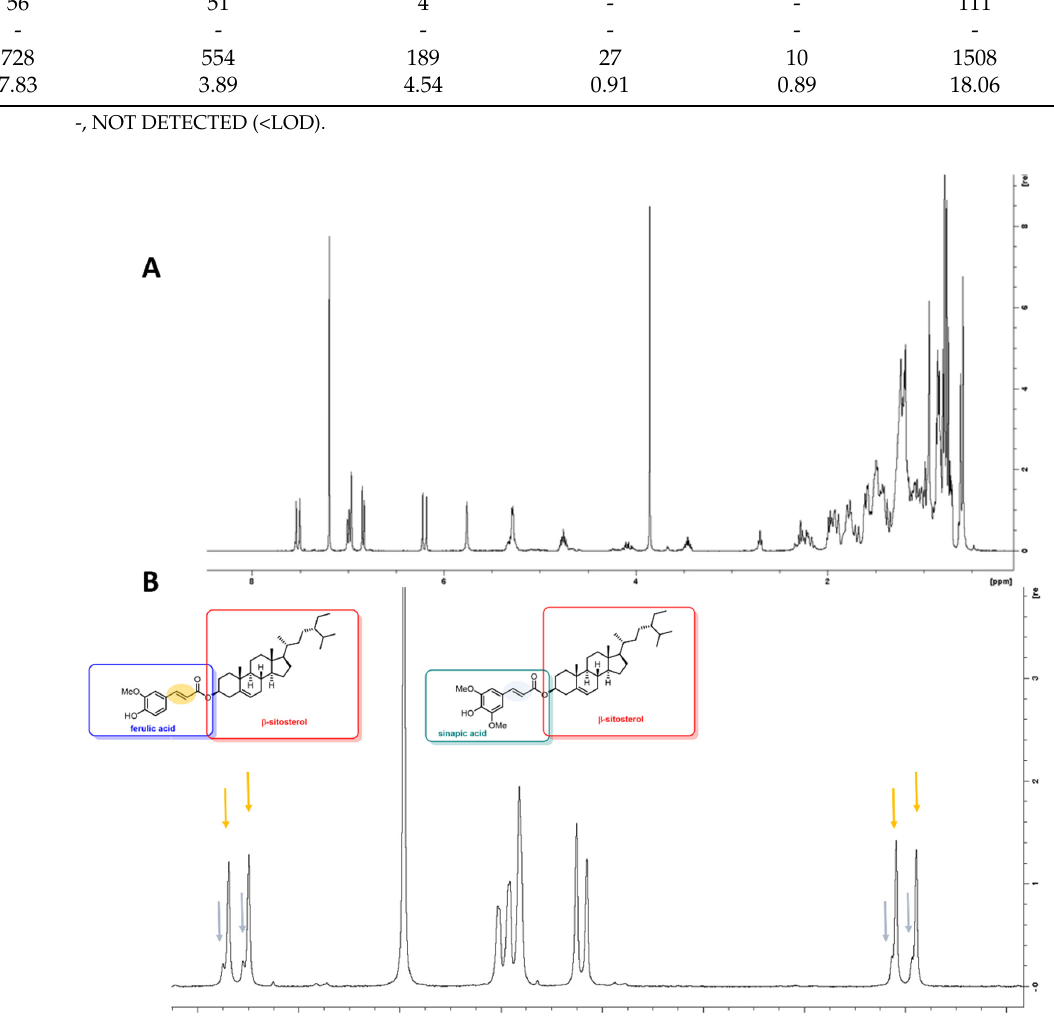
Figure 4. 1 H NMR of fraction 7a (Panel A ) and 1 H NMR of steryl-esters, olefinic region for deconvo- lution of fraction 7a (Panel B ).